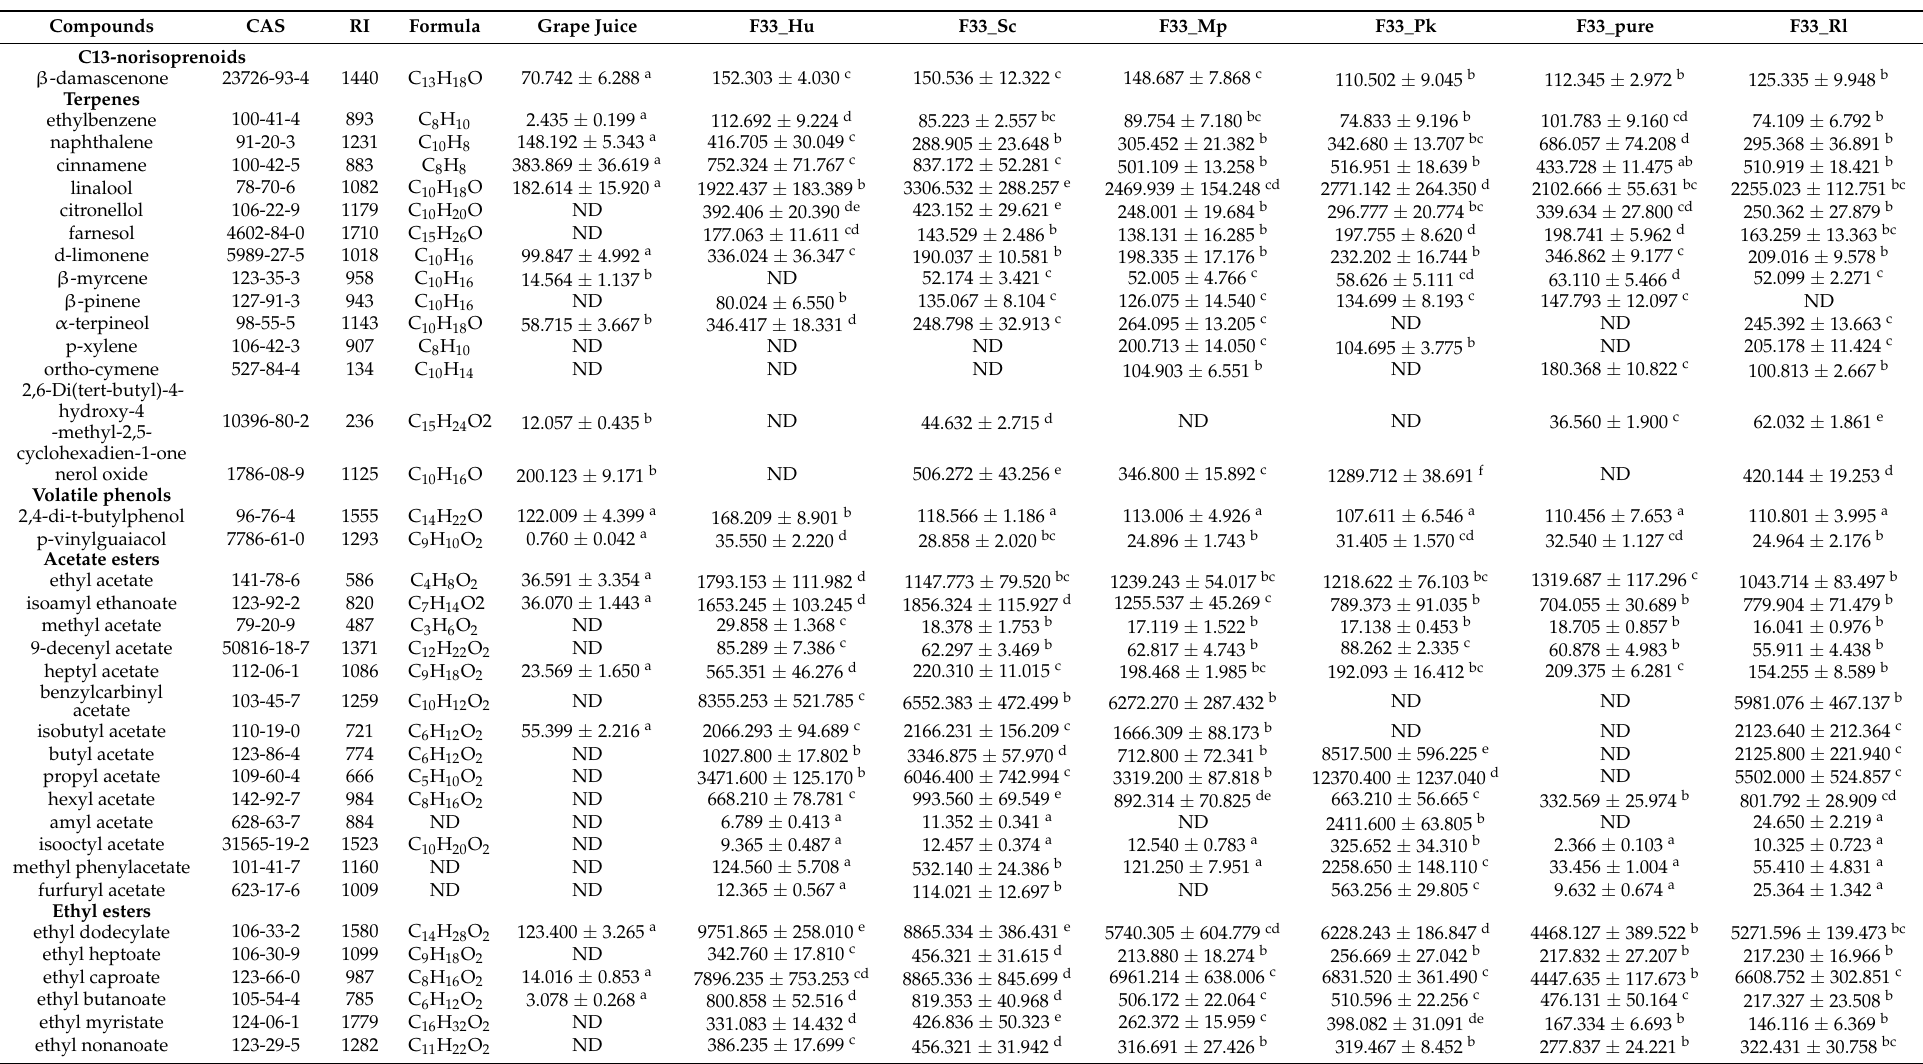
Table 3. All the individual volatile compounds ( µ g/L) from Vidal icewine fermented with six fermentation